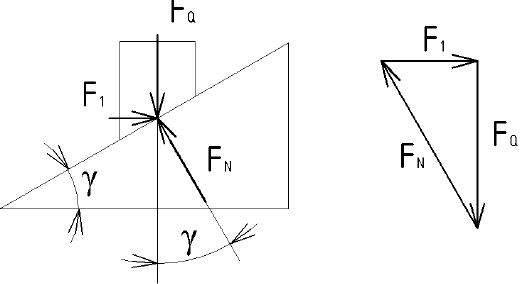
Figure 1. Ratio of the forces for frictionless motion.